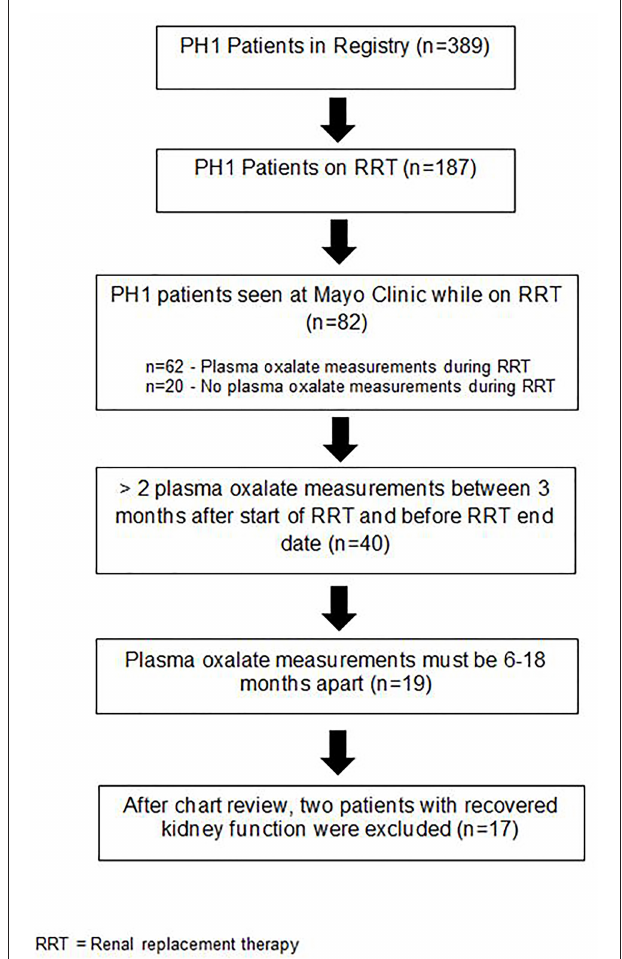
FIGURE 1 | Schematic of subject